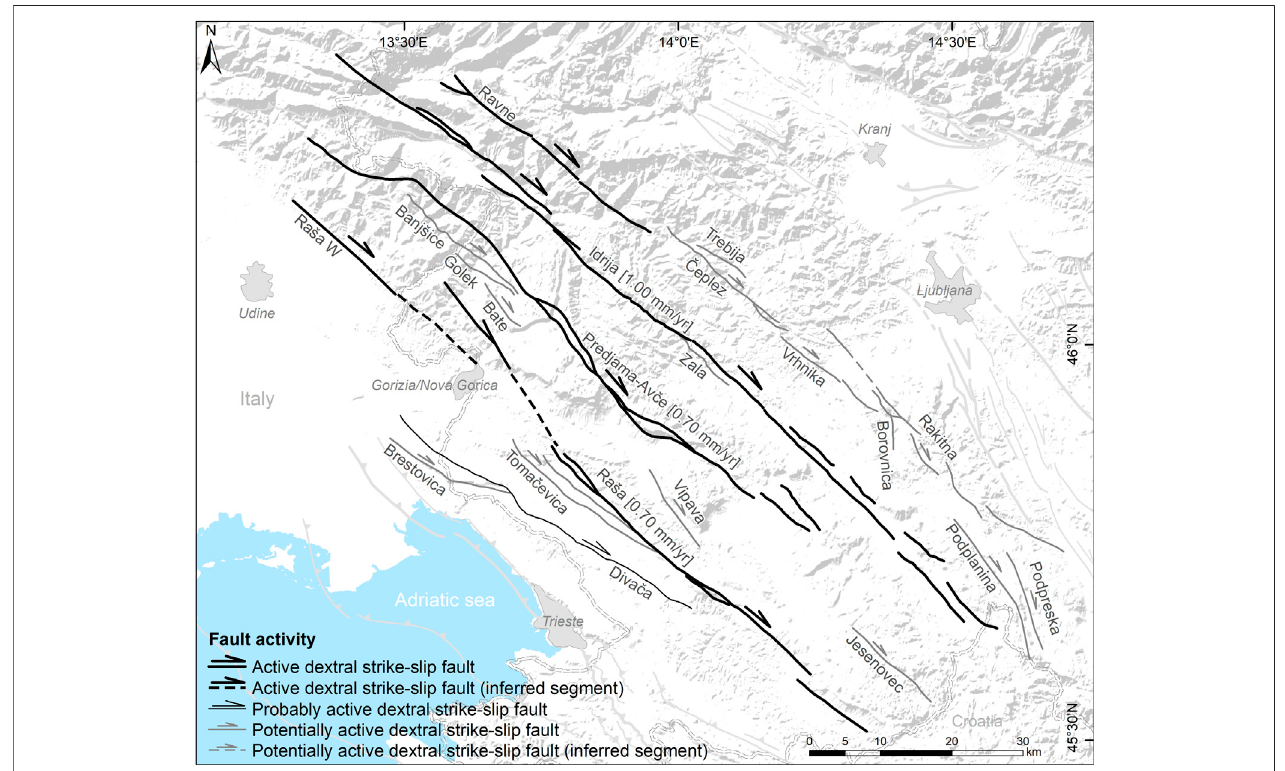
FIGURE 6 | Western fault set of the Dinaric fault system. The dominant faults are the Ra ˇ sa fault, the Predjama-Av ˇ ce fault and the Idrija fault.